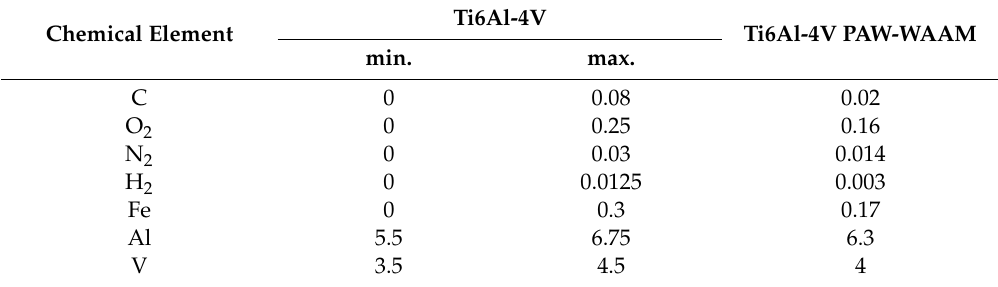
Table 5. Chemical composition of the PAW-WAAM material compared to the AMS4928 standard (wt %) related to forged material.